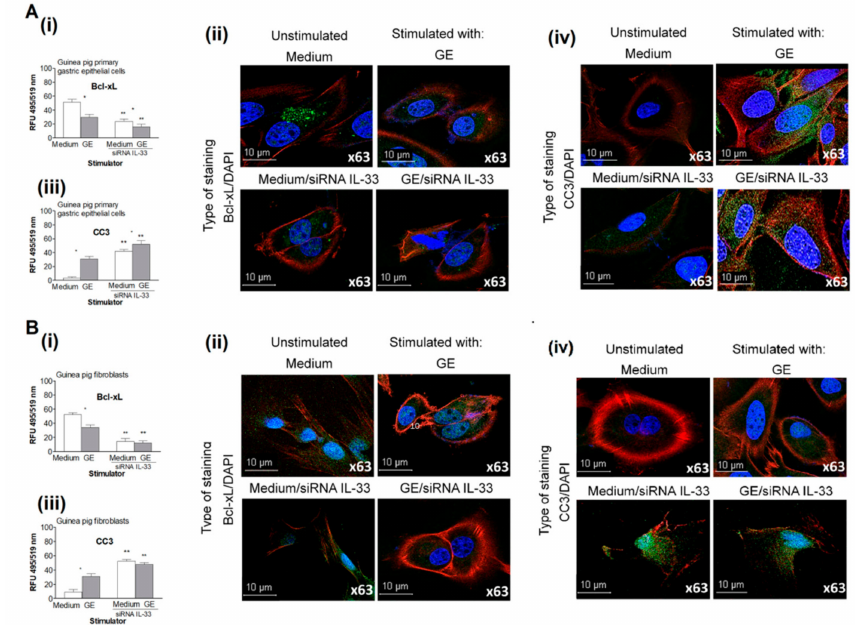
Figure 6. The expression of anti-apoptotic Bcl-xL and cleaved caspase 3 in cell cultures in vitro. Levels of anti-apoptotic Bcl-xL and cleaved caspase 3 (CC3) in cell cultures of guinea pig primary gastric epithelial cells ( A ) or fibroblasts ( B ), untransfected or transfected with siRNA cultured in medium only or exposed to H. pylori glycine acid extract (GE ).The level of intensity of Bcl-xL ( i ) and CC3 ( iii ) was measured using the Image J software version 1.48v (National Institute of health, United States). Representative images of cells stained for Bcl-xL ( ii ) or CC3 ( iv ) and photographed under 63x magnification in confocal microscope (LeicaTCS SP, Wetzlar, Germany)). 4 (cid:48)